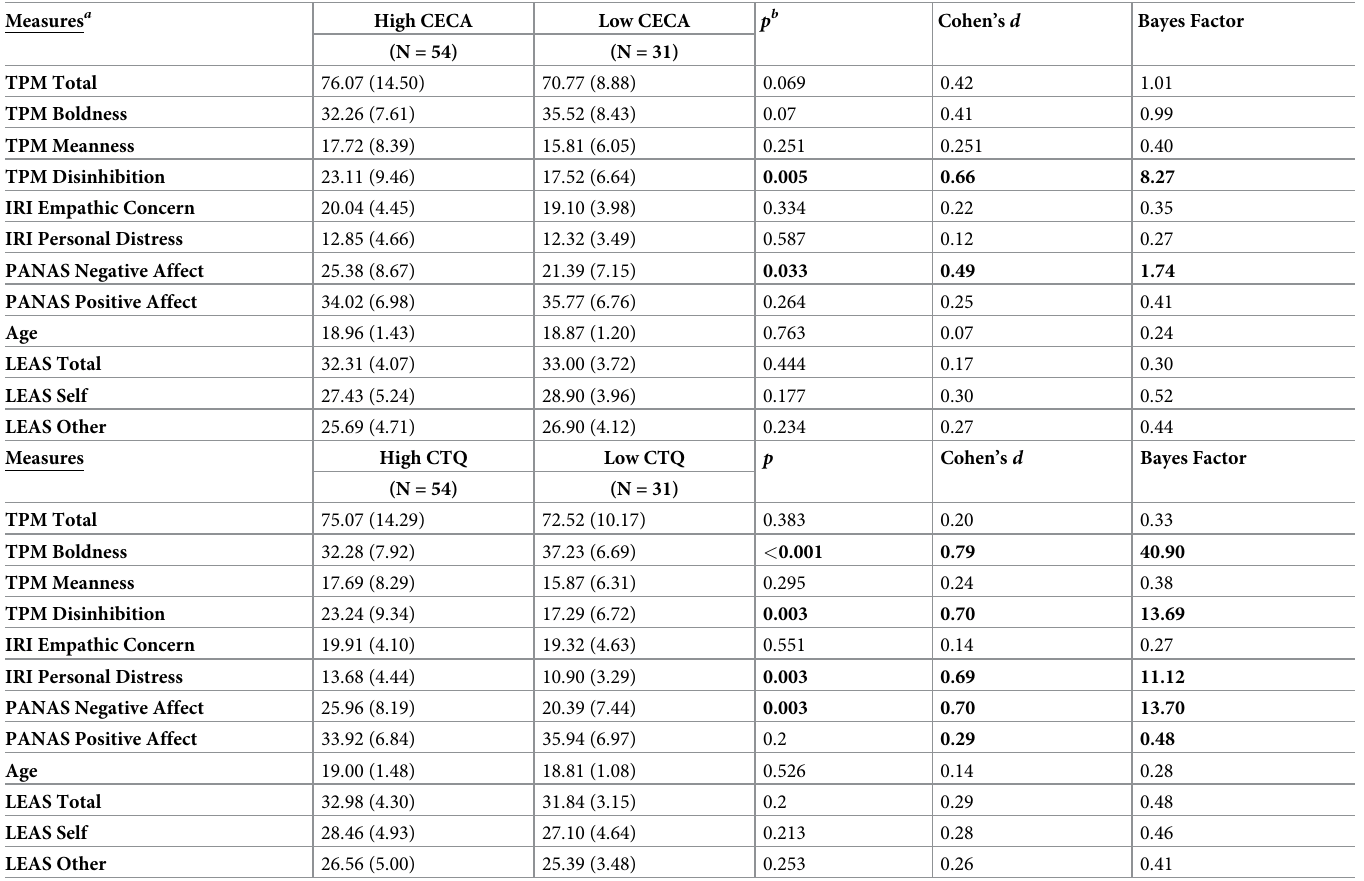
Table 2. Summary statistics (mean and SD) of measures in high-psychopathy group by early adversity